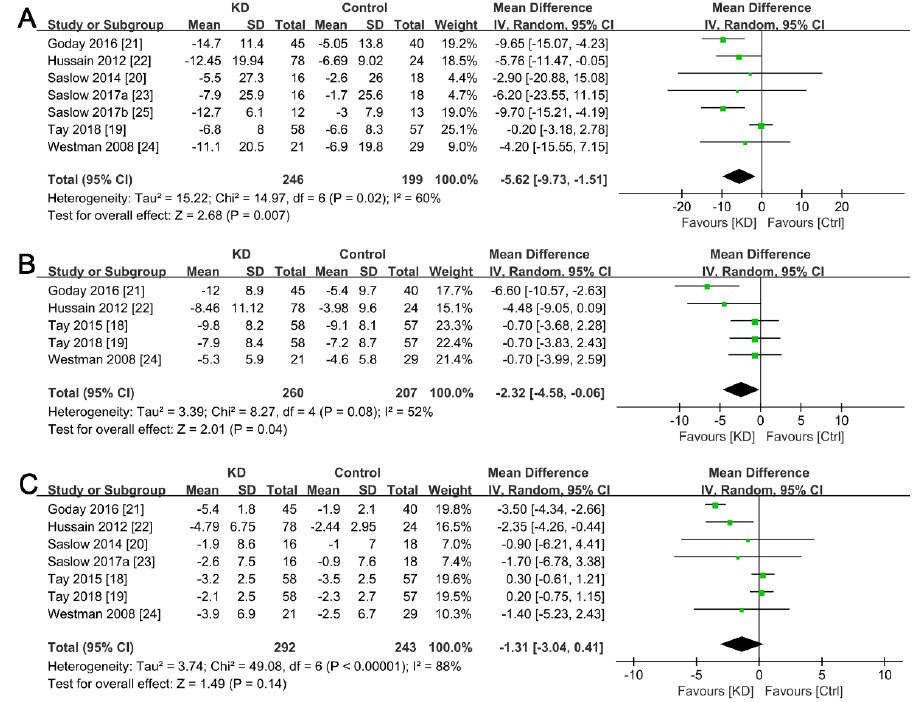
Figure 3. Forest plots for the effects of post-intervention versus baseline on weight change in overweight T2DM patients. ( A ) Changes in body weight; ( B ) Changes in waist circumference; ( C ) Changes in BMI. The green squares represent individual effect sizes, and the black diamonds represent pooling effect sizes.